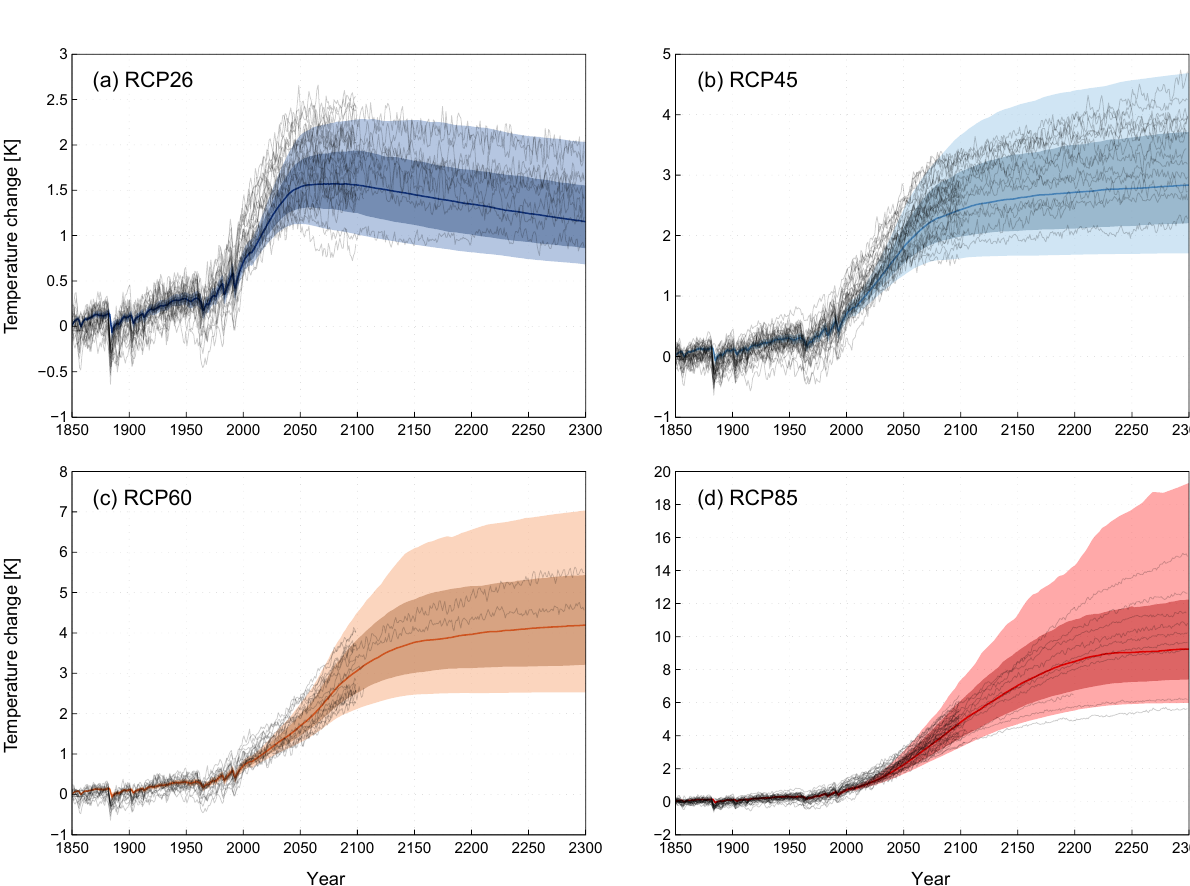
Figure 5. Global-mean tas projections until 2300 for all RCP extensions based on the historically constrained probabilistic MAGICC setup; 90% ensemble range in light colors, 66% ensemble range in darker colors, medians as solid lines. Available global CMIP5 tas reference time series are shown as thin black lines. All temperature projections are given relative to